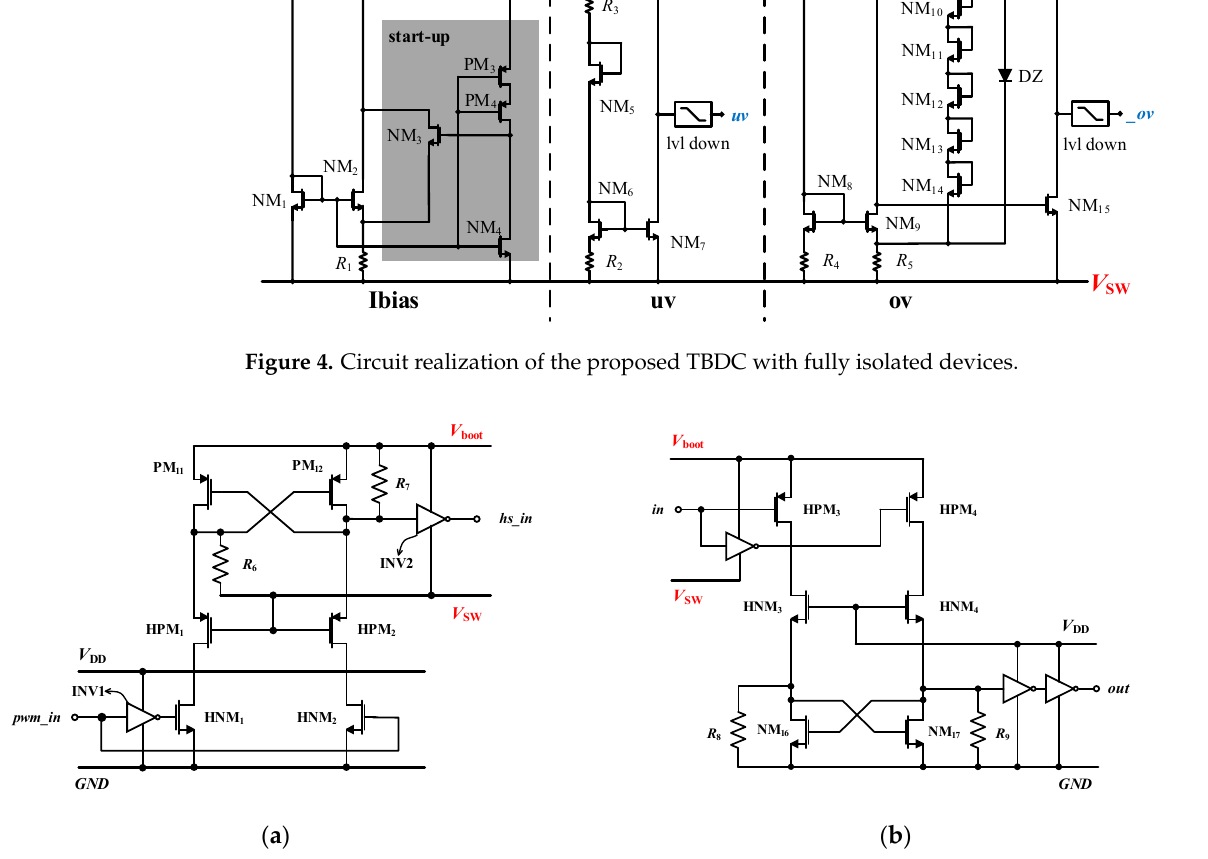
③ ① ② ③ Figure 6. Circuit realization of driver and waveforms of hs_in , gate of PM 10 and NM 16 . 2.2.1. TBDC Circuit •